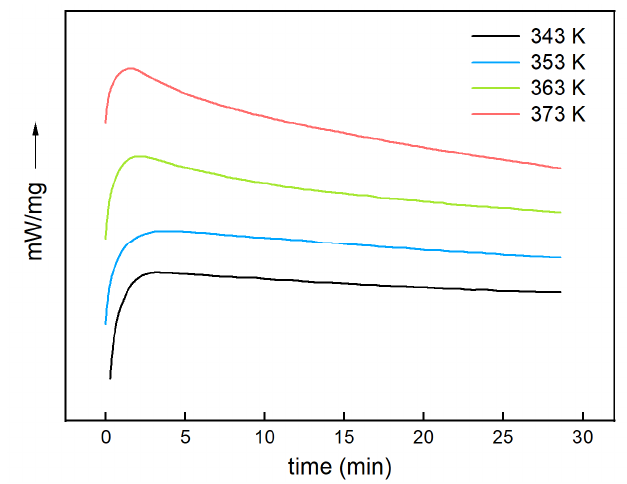
Figure 6. Iso–curing curves for the H 6 XDI/BES system. It can be seen in Figure 6 that more time was needed to increase the degree of cure with the curing process at the same temperature. At the initial stage of curing, the viscosity